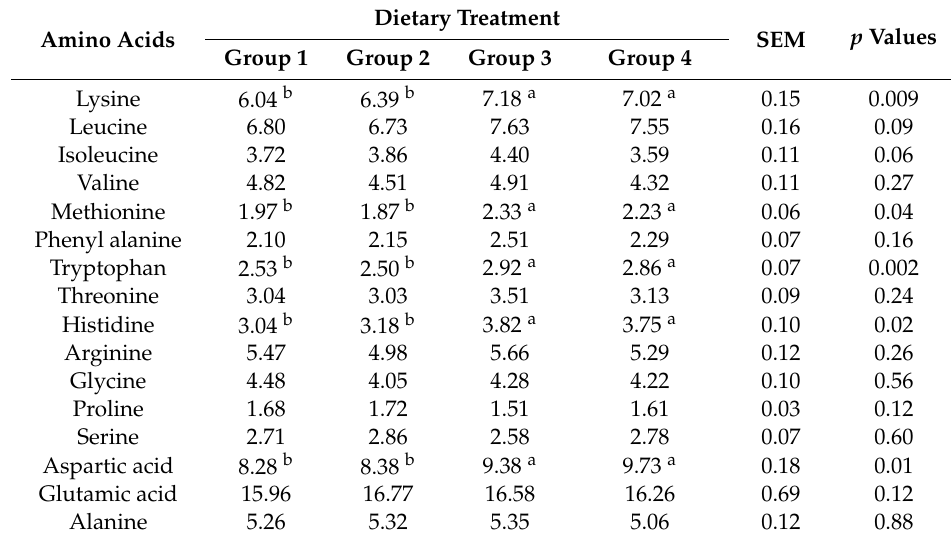
Table 6. Profiles of amino acids in breast muscle of broilers chickens fed di ff erent species of microalgae for 32 days.